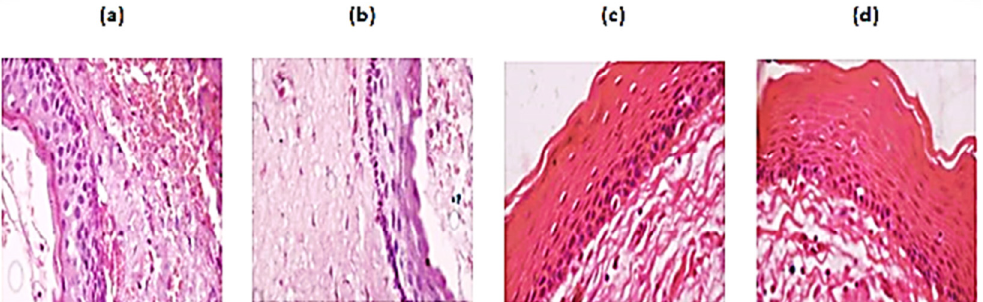
Figure 2. The representative samples of histopathological slides of recurrent (( b ) subepithelial hyalin- ization & ( d ) corrugated surface) and non-recurrent OKC (( a ) absence of subepithelial hyalinization & ( c ) absence of corrugated surface).